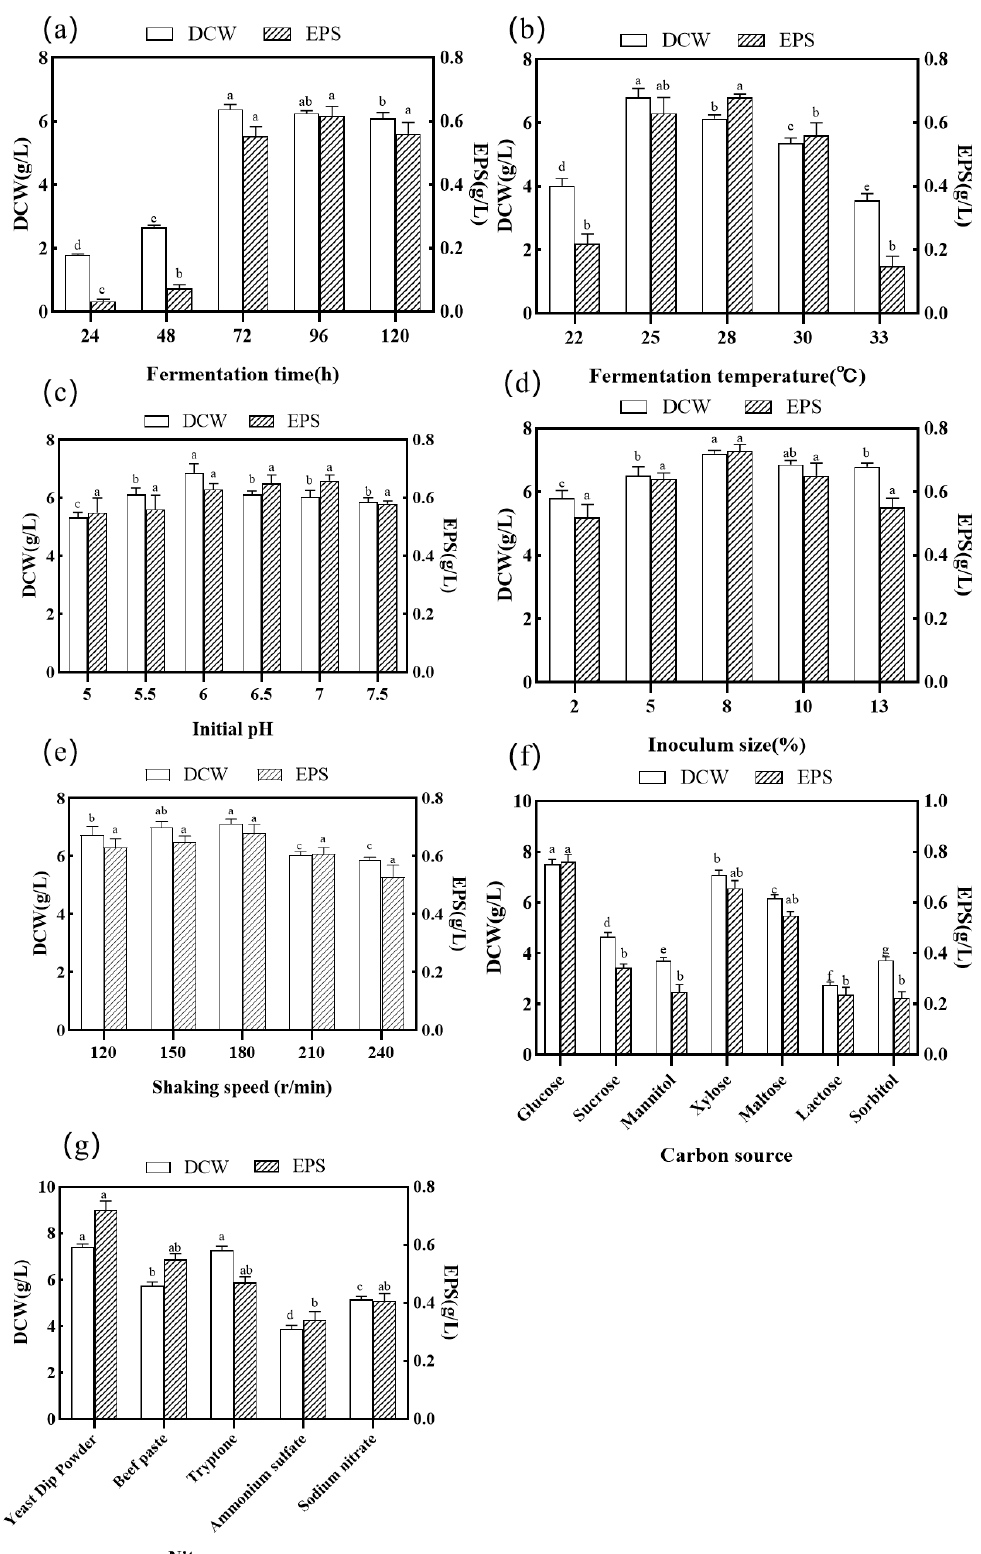
Figure 3. Effects of each variable factor on the yield of EPS and DCW from Tf526 strain: ( a ) culture time; ( b ) culture temperature; ( c ) Initial pH; ( d ) Inoculum size; ( e ) shaking speed; ( f ) Carbon source; ( g ) Nitrogen source. Data are expressed as mean ± SD, n = 3. Values with no letters in common are significantly different ( p <